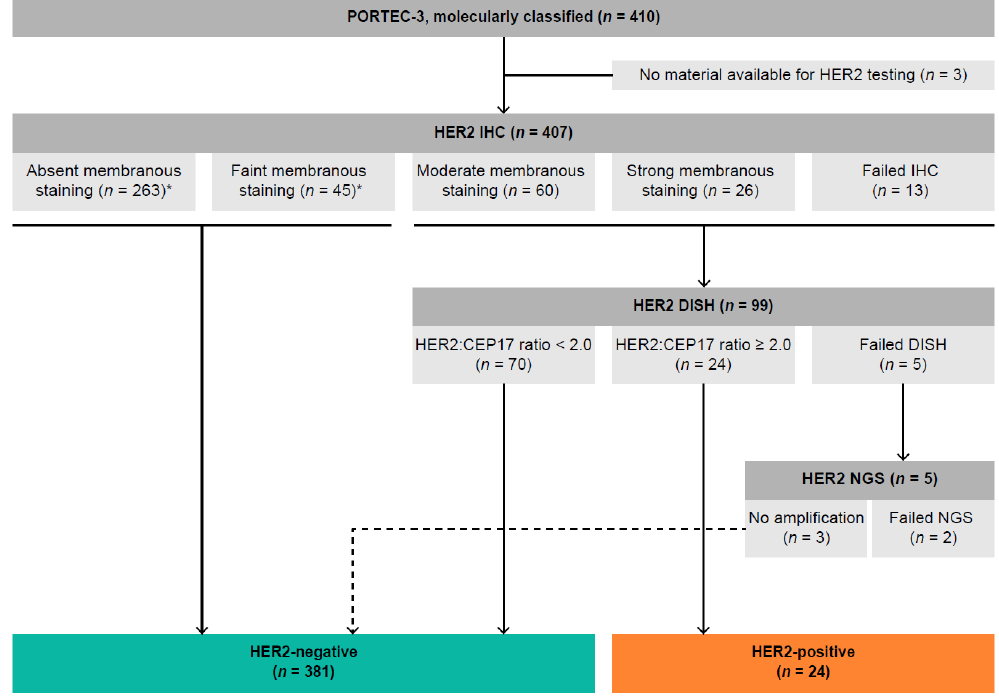
Figure 1. Flowchart of HER2 testing of molecularly classified PORTEC-3 trial participants. * SISH was performed on a random selection of cases with absent ( n = 10) and faint ( n = 10) membranous staining to confirm the absence of HER2 amplification. Abbreviations: IHC, immunohistochemistry; SISH, silver in situ hybridization; NGS, next-generation sequencing.